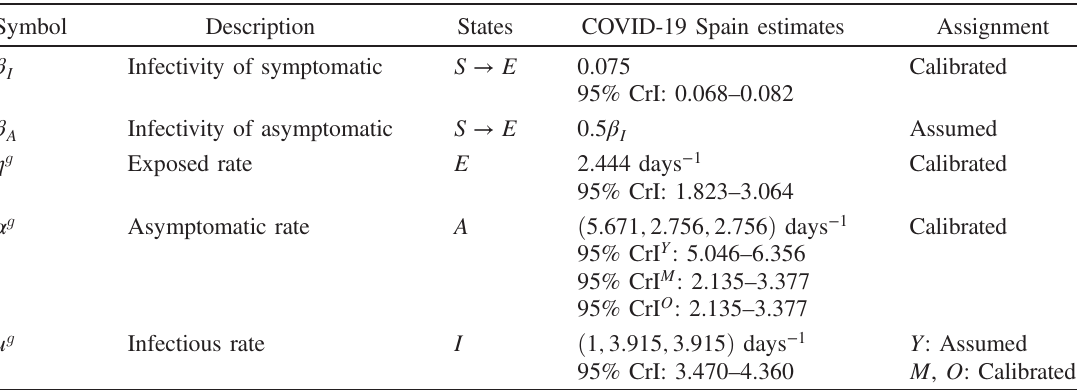
TABLE II. Epidemic parameters of the model and their estimations with 95% credible intervals for COVID-19 in Spain, with strata separation g ∈ f Y; M; O g when appropriate. See Appendix A for a detailed